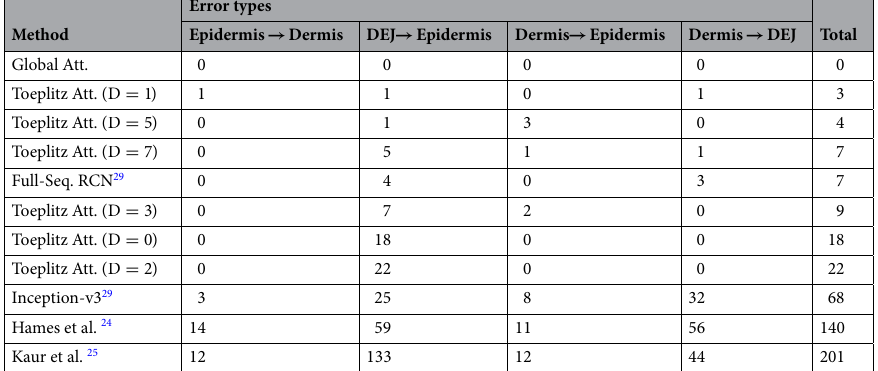
Mean absolute error ( µ m ) Epidermis-DEJ Boundary DEJ-Dermis Boundary